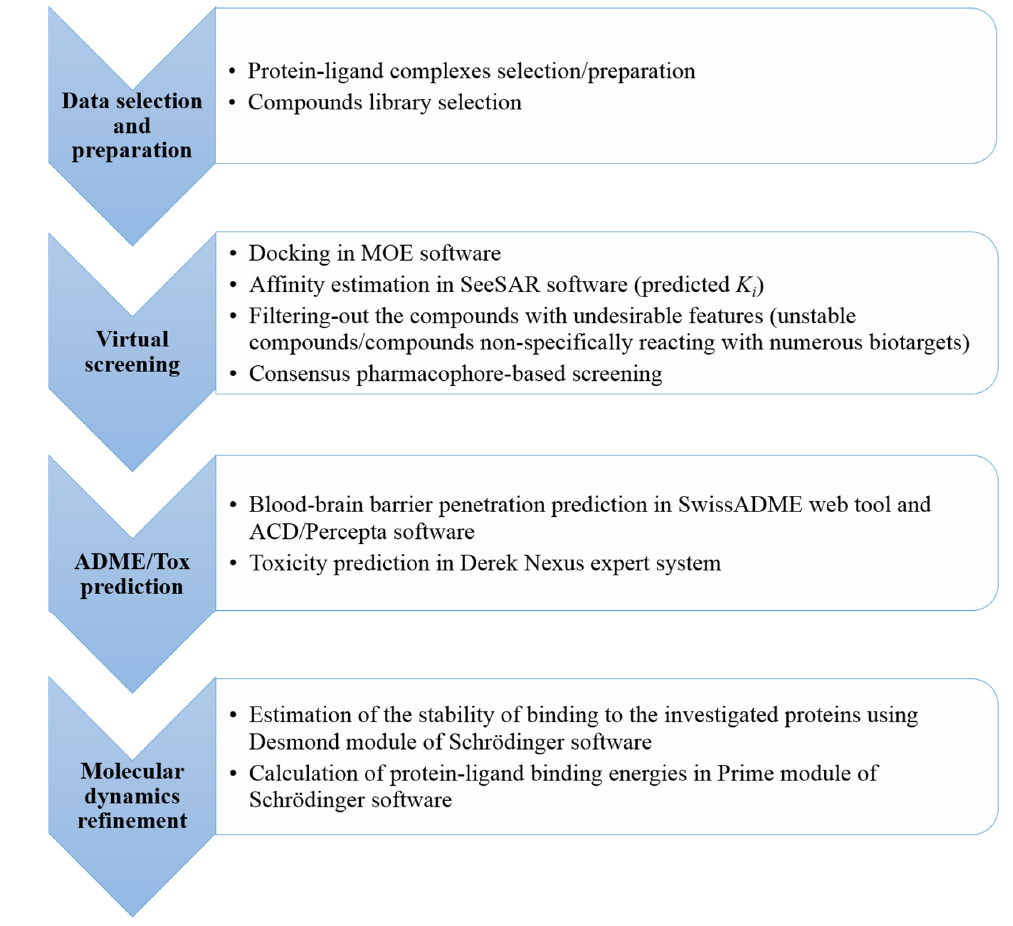
Figure 2. A flowchart representing the computational workflow with the main steps/approaches applied to identify the hit compounds toward AChE, HDAC2 and MAO-B enzymes.